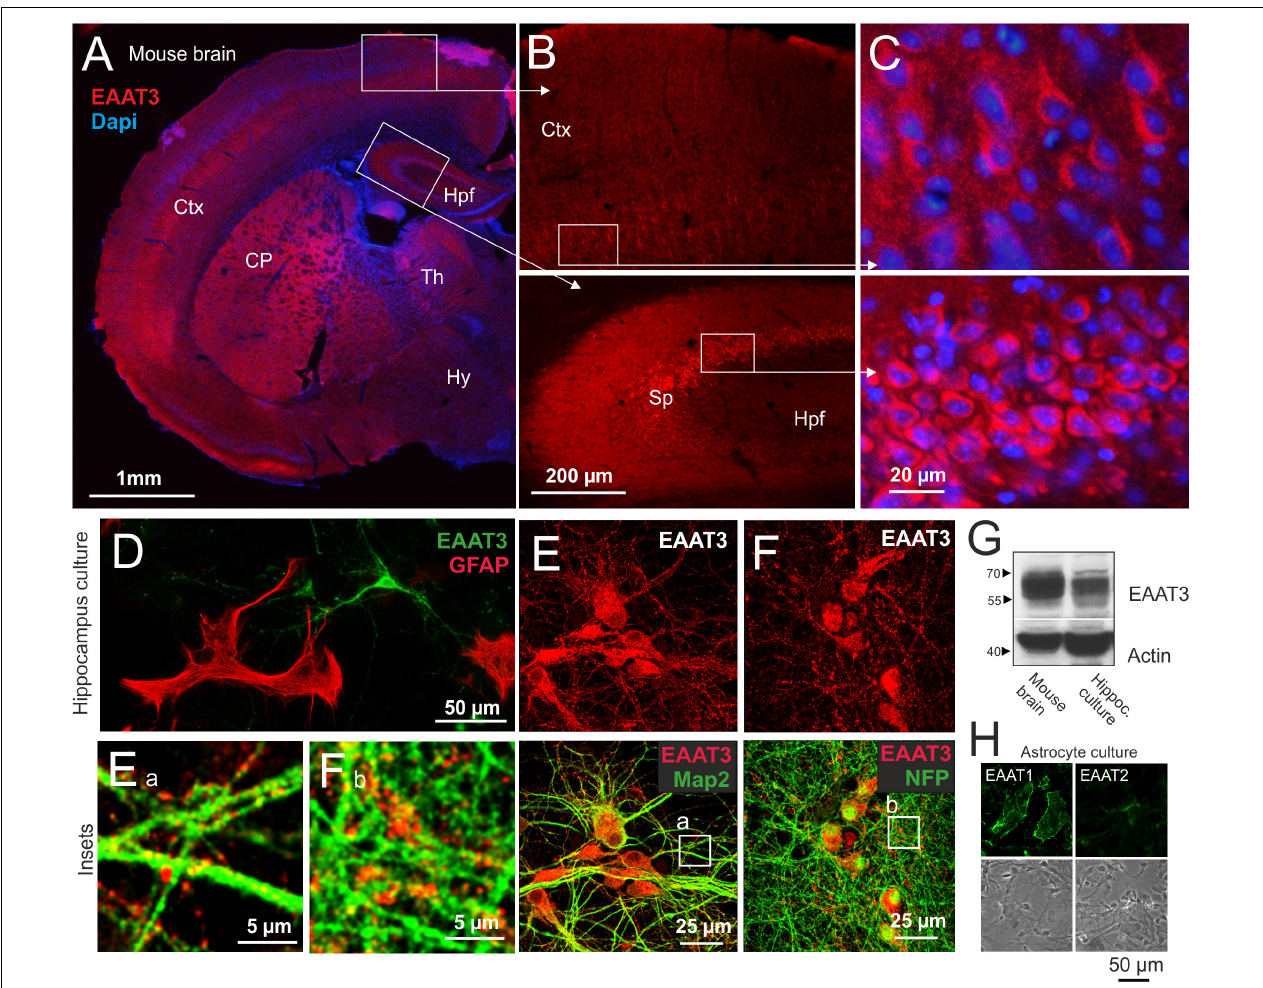
FIGURE 1 | Expression of the excitatory amino acid transporter 3 (EAAT3) in mouse brain and primary hippocampal neurons. (A–C) Expression pattern of EAAT3 in the adult mouse brain. Coronar cryosections of adult mouse brains were incubated with a polyclonal antibody directed against EAAT3. Protein expression was detected in neuronal perikarya and the neuropil of various brain areas, including caudate putamen, cortex and the hippocampus formation. Insets show enlargements of depicted areas. CP, Caudate putamen; Ctx, Cortex; Hpf, Hippocampus formation; Hy, Hypothalamus; Sp, Stratum pyramidale; Th, Thalamus. (D) Mouse hippocampal neurons were prepared at embryonic day 16, cells were grown on glass cover slips for 14 days, fixed and stained for EAAT3 and GFAP as marker for astrocytes present to some extent in culture. EAAT3 expression was restricted to neurons. (E,F) Mouse hippocampal neurons were prepared and cultured as described, fixed and stained for EAAT3, Map2 as dendritic (E) and NFP as axonal marker (F) by immunofluorescence methods and confocal imaging. EAAT3 staining was observed in a punctuate fashion throughout the cell body as well as dendritic and axonal processes [lower panels, see also insets (E a ,F b ) ]. (G) Homogenates of whole mouse brains and cultured hippocampal neurons were subjected to Western blot procedure and probed for the expression of neuronal EAAT3. Actin was used as loading control. The antiserum detected a major band between the 55 and 70 kDa markers in both samples. Overall, the signals corresponded well with the expected molecular weight. (H) Murine astrocytes were cultured close to confluency, fixed and stained for the main glial glutamate transporter EAAT1 (GLAST) and EAAT2 (GLT-1) by immunofluorescence and confocal imaging. Astrocytes predominantly expressed EAAT1 at the plasma membrane. EAAT2 expression was observed at comparably low